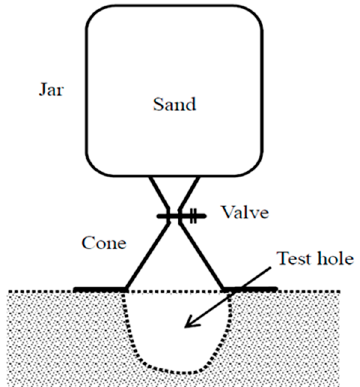
Figure 1. Schematic of field density measurement of compacted soil for sand cone test [17].